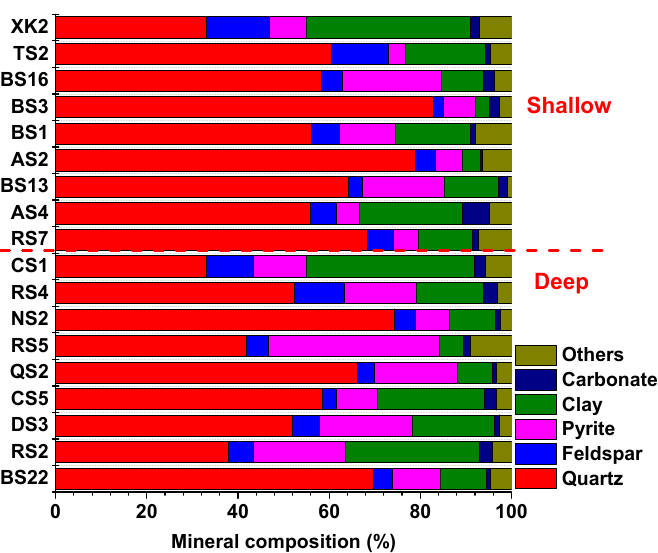
Figure 10. Mineral Figure 10. Mineral composition.